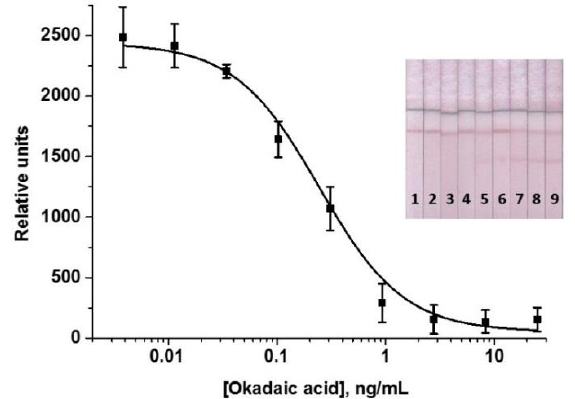
Figure 6. Calibration curve of OA in the enhanced LFIA ( n = 3) and the corresponding test strips. Concentrations of OA were 25 ng/mL (1); 8.3 ng/mL (2); 2.8 ng/mL (3); 0.93 ng/mL (4); 0.31 ng/mL (5); 0.10 ng/mL (6); 34 pg/mL (7); 1.2 pg/mL (8); 0.04 pg/mL (9).